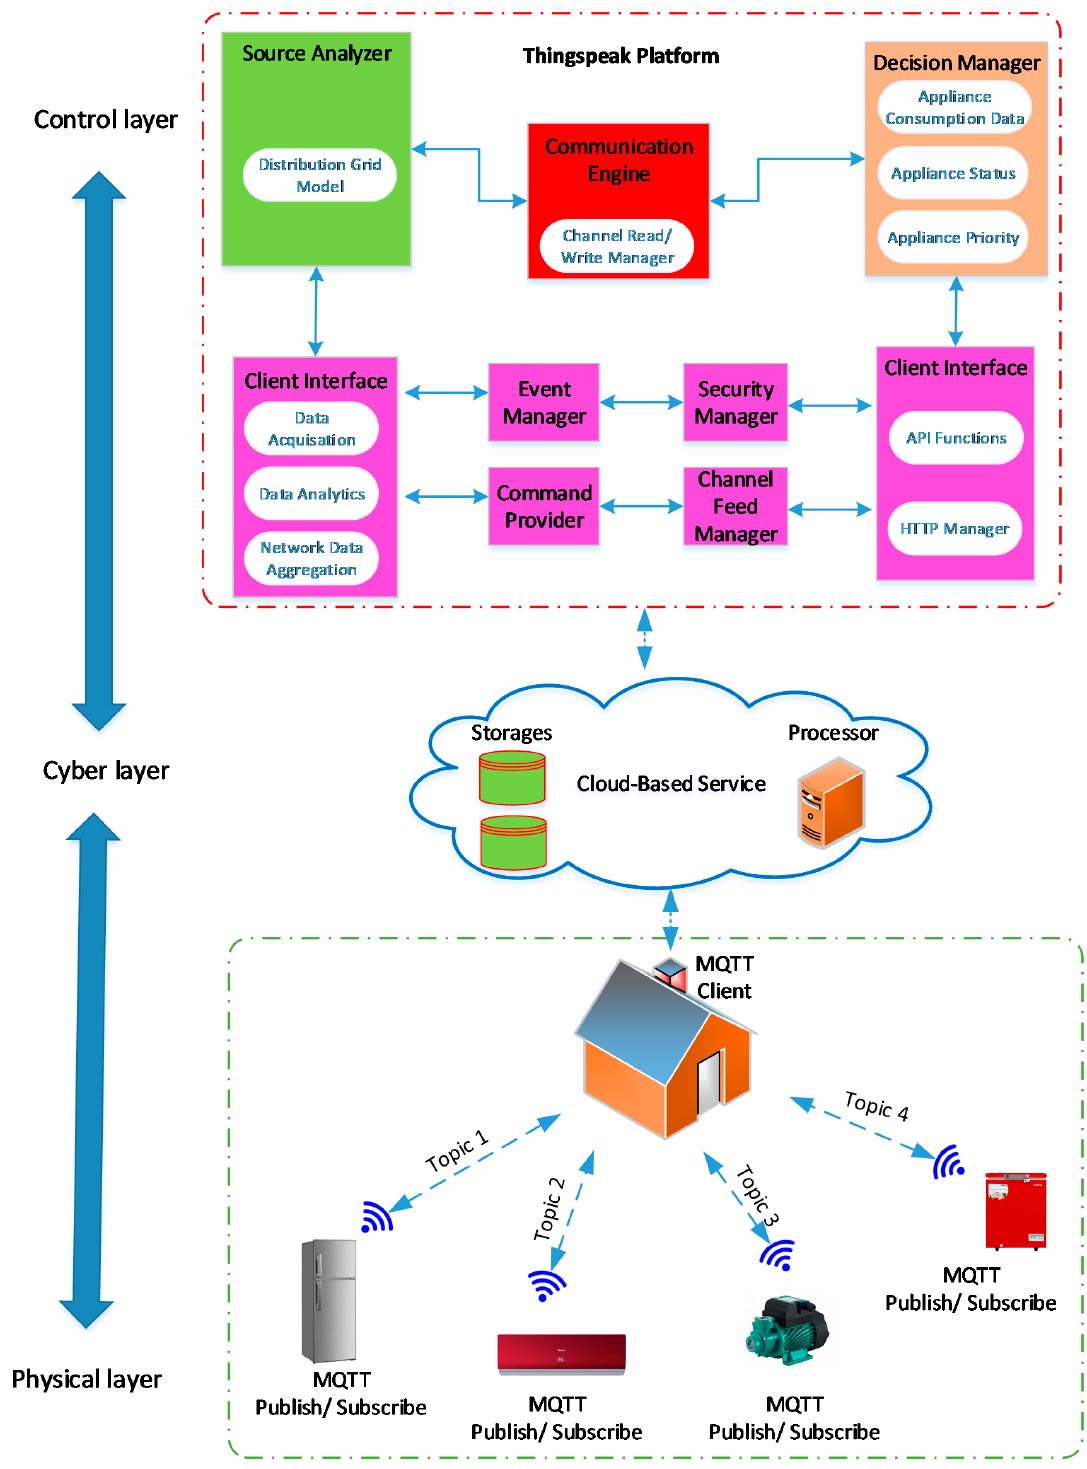
Figure 4. Smart home proposed architecture of communication.